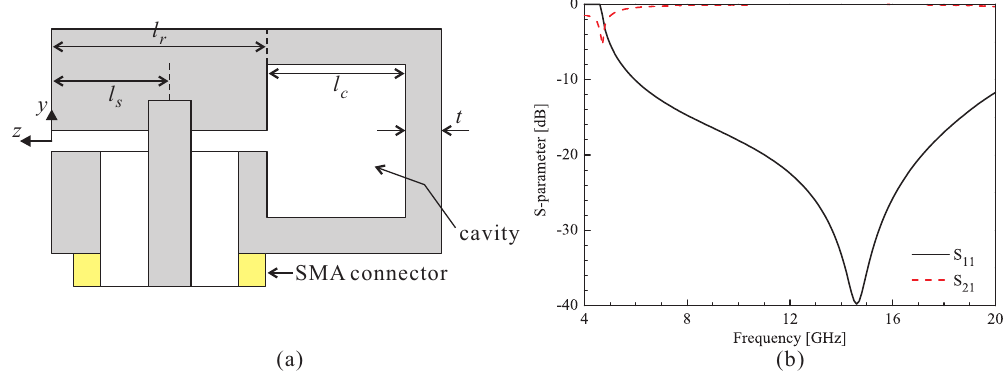
Figure 4. ( a ) yz -plane view and ( b ) simulated S-parameters of the